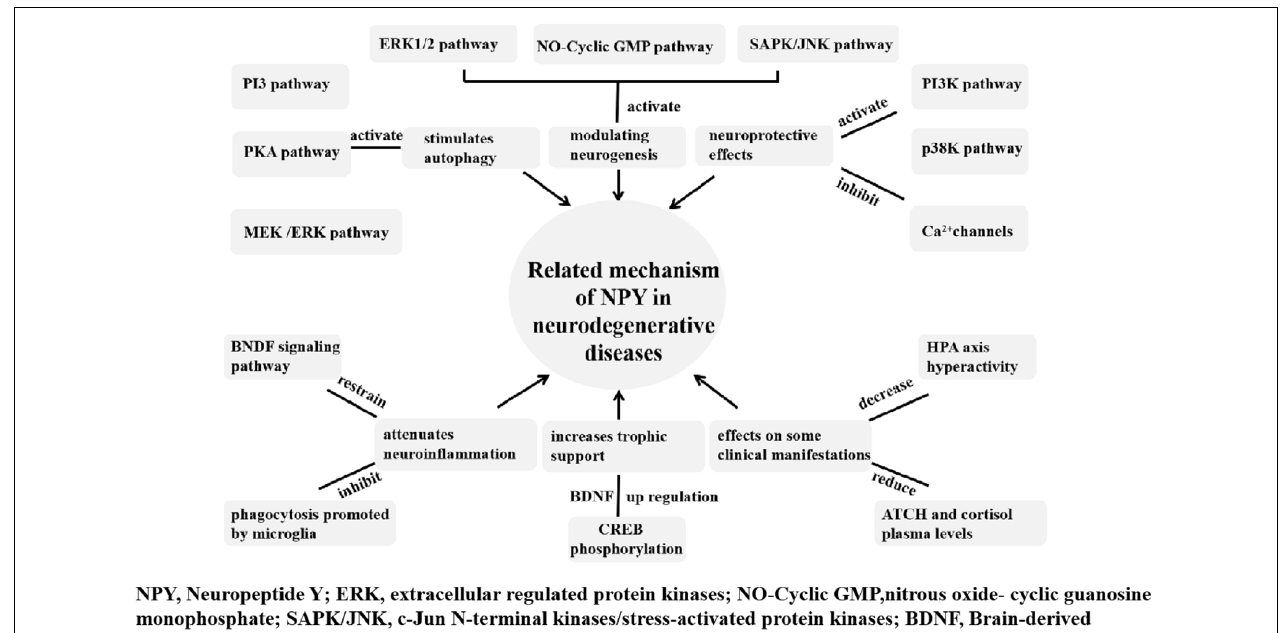
FIGURE 1 | Related mechanism of NPY in neurodegenerative diseases. The neuroprotective and anti-neuroinflammatory roles of NPY in neurodegenerative diseases include modulating neurogenesis, increasing trophic support, exerting neuroprotective effects, affecting some clinical manifestations, attenuating neuroinflammation, and stimulating